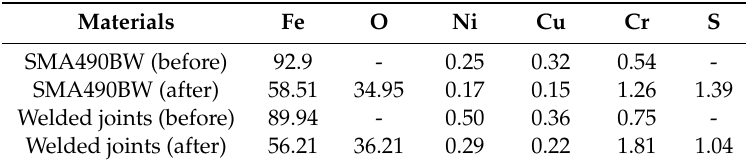
Table 5. Main chemical composition of SMA490BW steel and its welded joints before and after the periodic immersion wet / dry cyclic corrosion test (wt